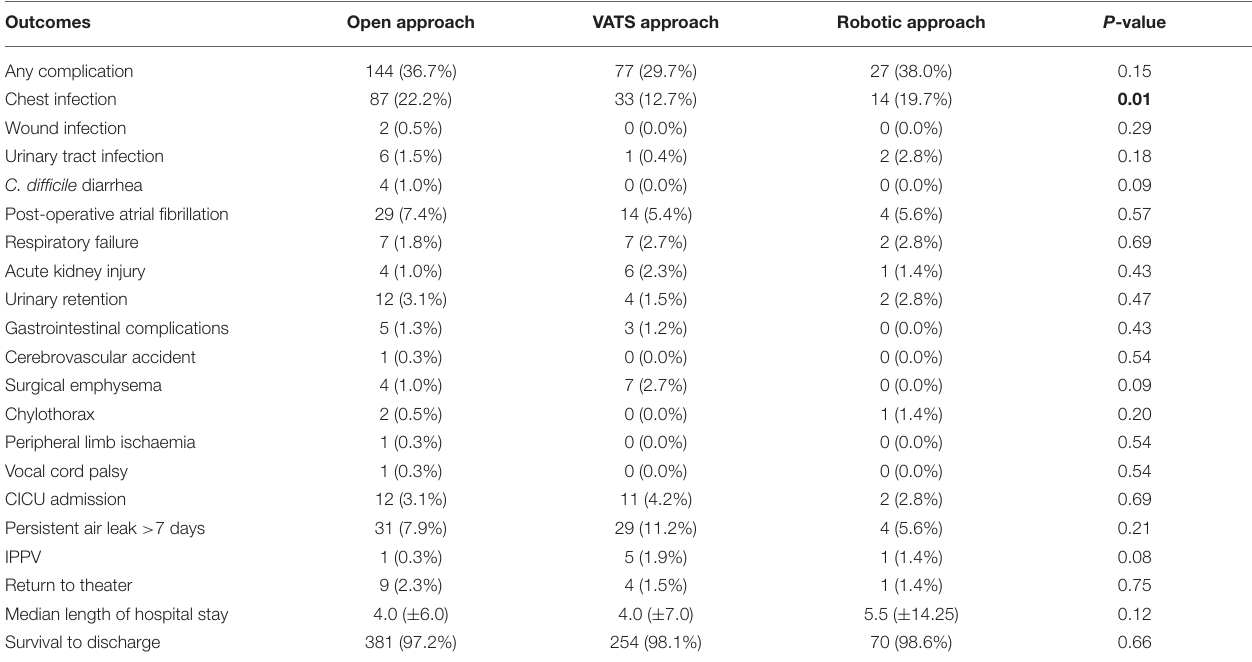
TABLE 5 | Post-operative complications per surgical